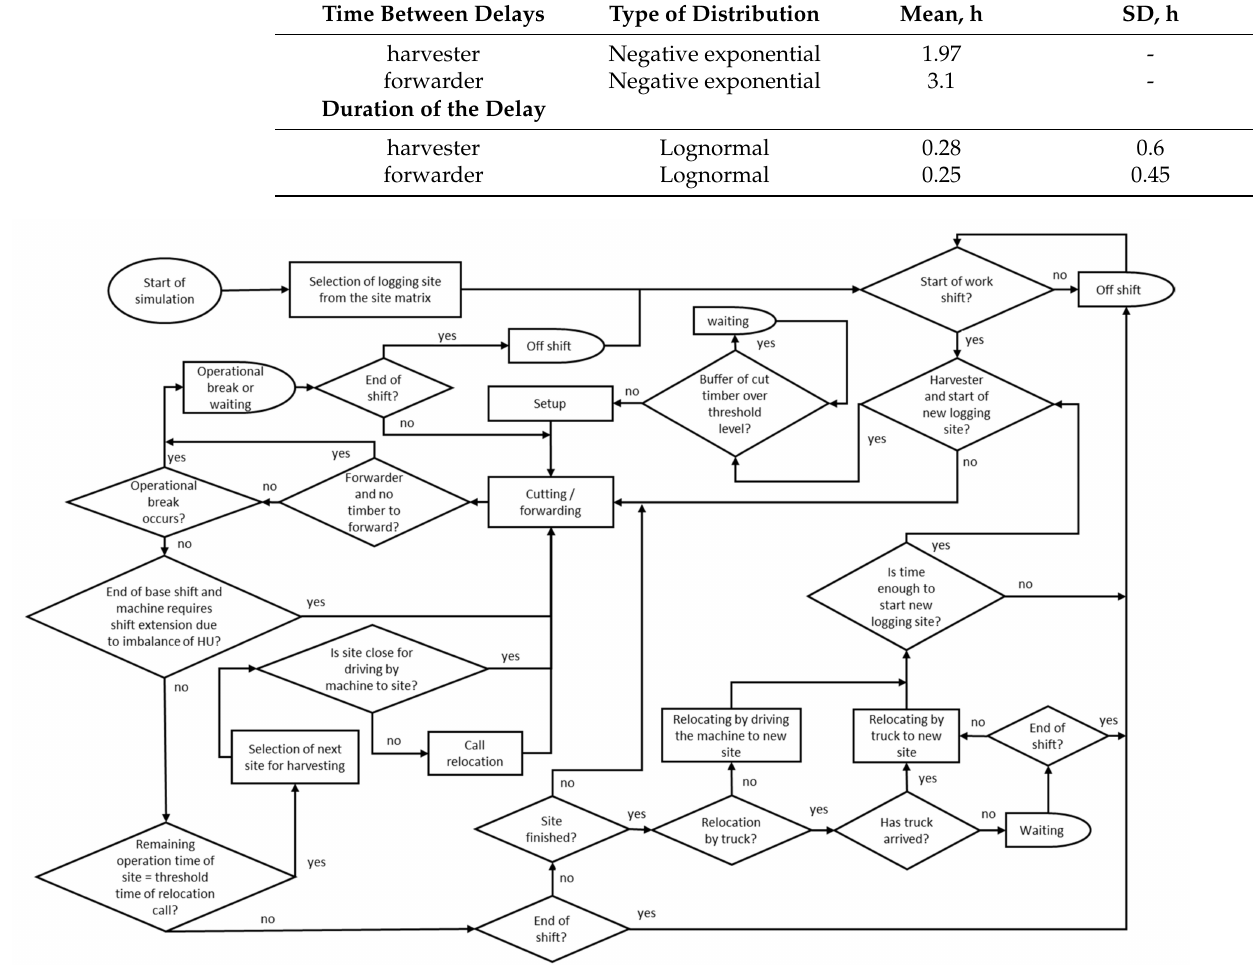
Figure 3. Flowchart of the process flow of machine operations (i.e., cutting by a harvester and forwarding by a forwarder), with the most decisive conditional expressions influencing